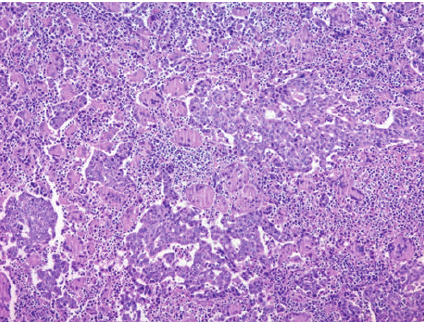
Figure 1: Nests of poorly differentiated squamous cells with interspersed osteoclastic giant cells. H&E stain, × 50.